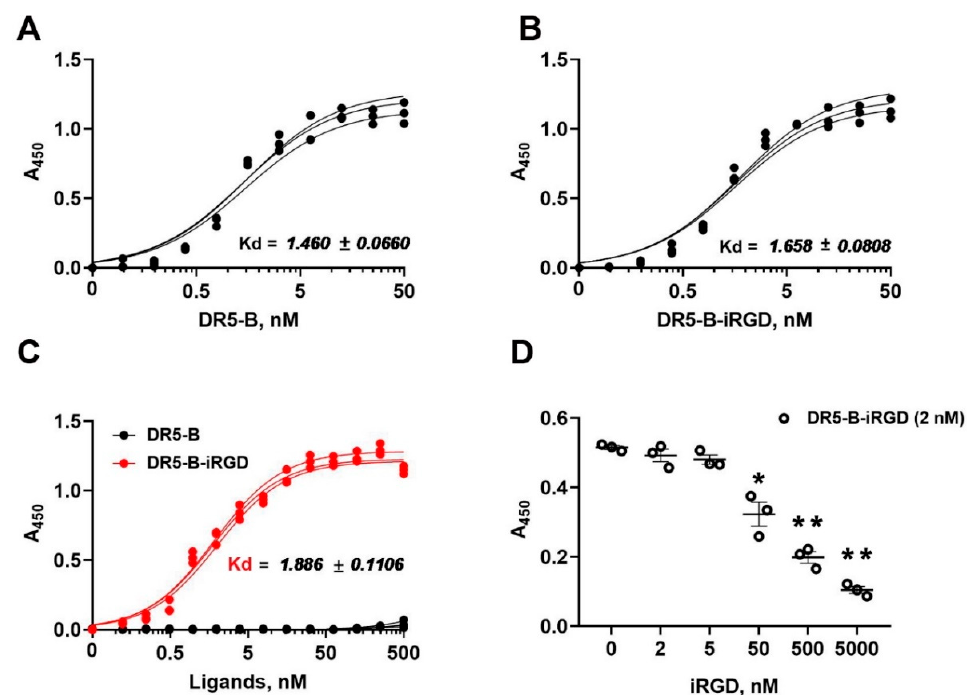
Figure 2. The binding affinity of DR5-B-iRGD protein for receptors DR5 and integrin α v β 3 analyzed by enzyme-linked immunosorbent assay (ELISA). ( A ) Affinity of DR5-B for the DR5 receptor. ( B ) Affinity of DR5-B-iRGD for the DR5 receptor. Significant difference between affinities of DR5-B and DR5-B-iRGD to DR5 receptor ( p = 0.0303) was observed according to Student’s t-test. ( C ) Comparison of the affinities of DR5-B and DR5-B-iRGD for the integrin α v β 3. ( D ) Competitive binding of DR5-B-iRGD protein (2 nM) and free iRGD peptide to integrin α v β 3. * p < 0.005 and ** p < 0.001 indicate significant difference from the control according to one-way ANOVA followed by Dunnett’s post hoc test. K D values were calculated from three independent experiments by the non-linear regression option in GraphPad Prism 8.0.